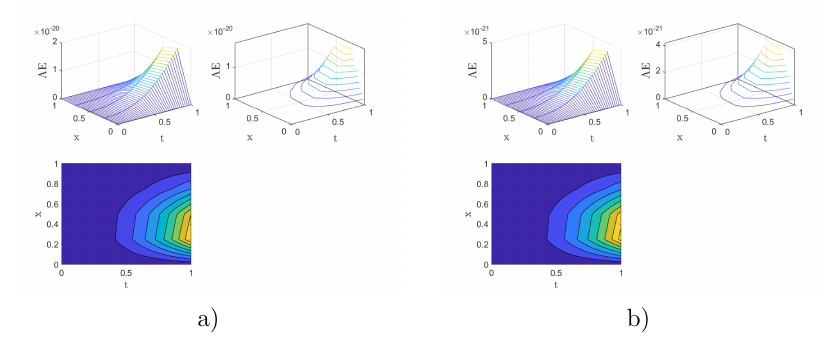
Figure 2. The AE functions of applying the proposed method for M = M ′ = 32, η = η 1 = 1 ( a ), M = M ′ = 64 and η = η 1 = 1 2